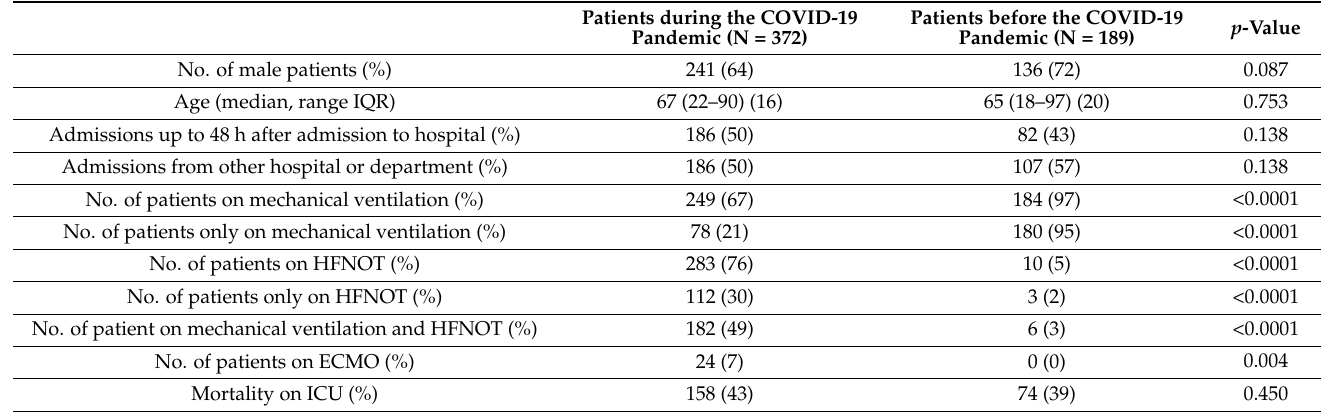
Figure 1. Distribution of admission diagnoses in the Department of Anesthesiology, Resuscitation and Intensive Care before the COVID-19 pandemic. ARDS — acute respiratory distress syndrome. Table 1. Characteristics of the examined groups of patients before and during the COVID-19 pan- demic. p -value in bold type means statistically significant differences between the two groups.